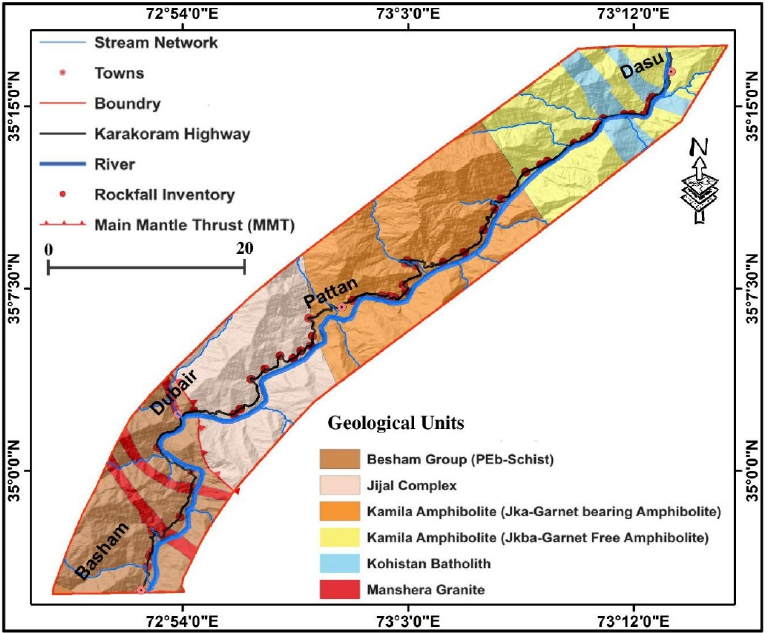
Figure 4. Geological Road log showing the locations of rockfalls, debris slides, and topples along the highway (Modified from Geological Survey of Pakistan Road Log).